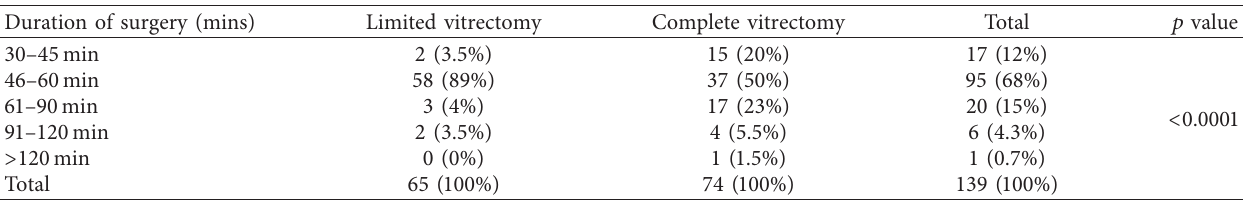
Table 3: Comparison of duration of surgery of ERM+ ILM peeling groups in limited versus complete vitrectomy groups.